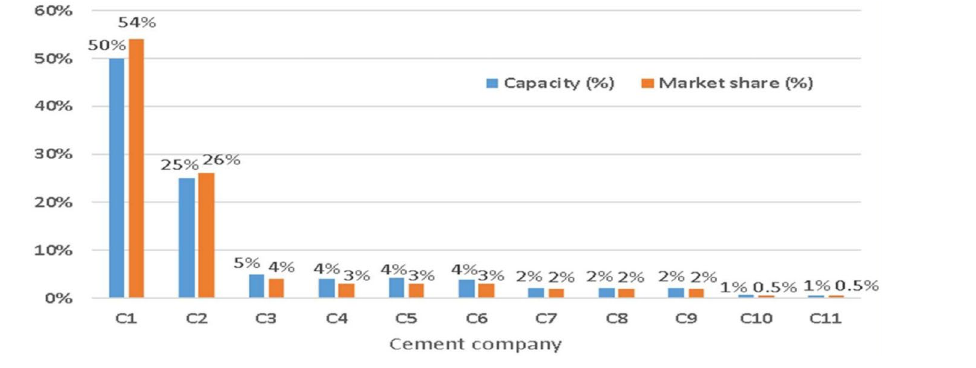
Figure 5. Geography of cement supply, Indonesia, 2018 89,91